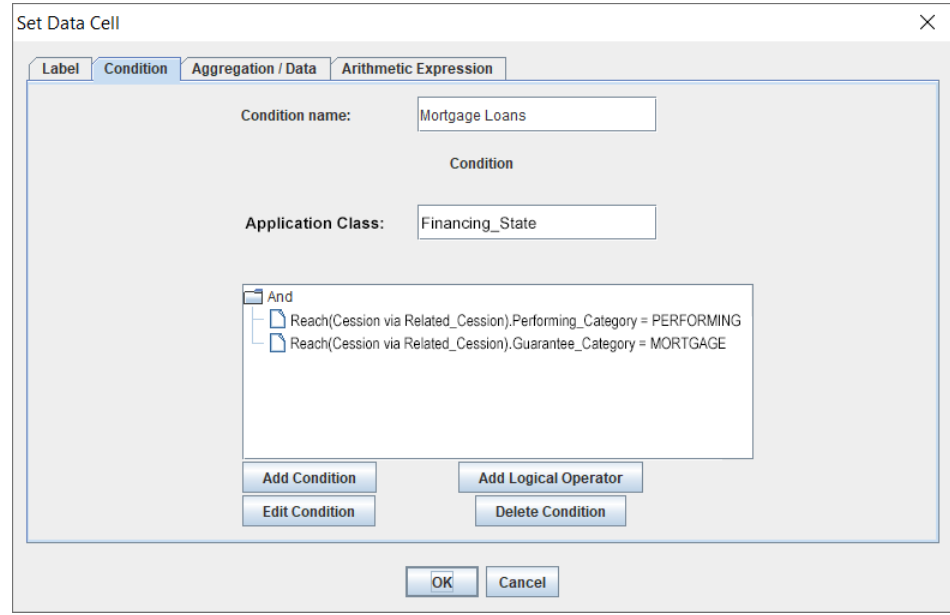
Figure 15. Report Designer : user interface for defining “Condition Cells”.